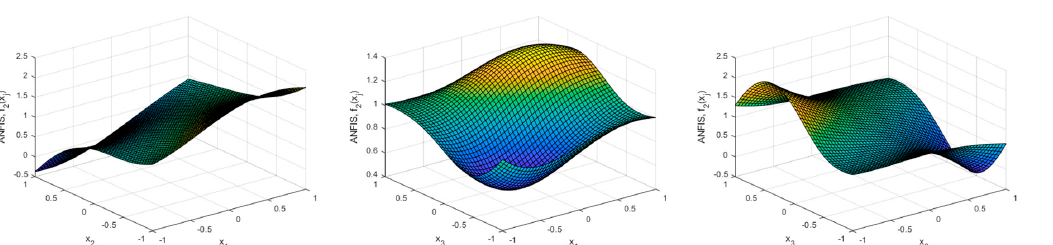
Figure 29. Best MSE and obtained squared-R (Number of Epochs = 46, 𝑘 (cid:3007)(cid:3010)(cid:3020) = 0.87 , 𝑁 (cid:3007)(cid:3010)(cid:3020) = 1.66 ).